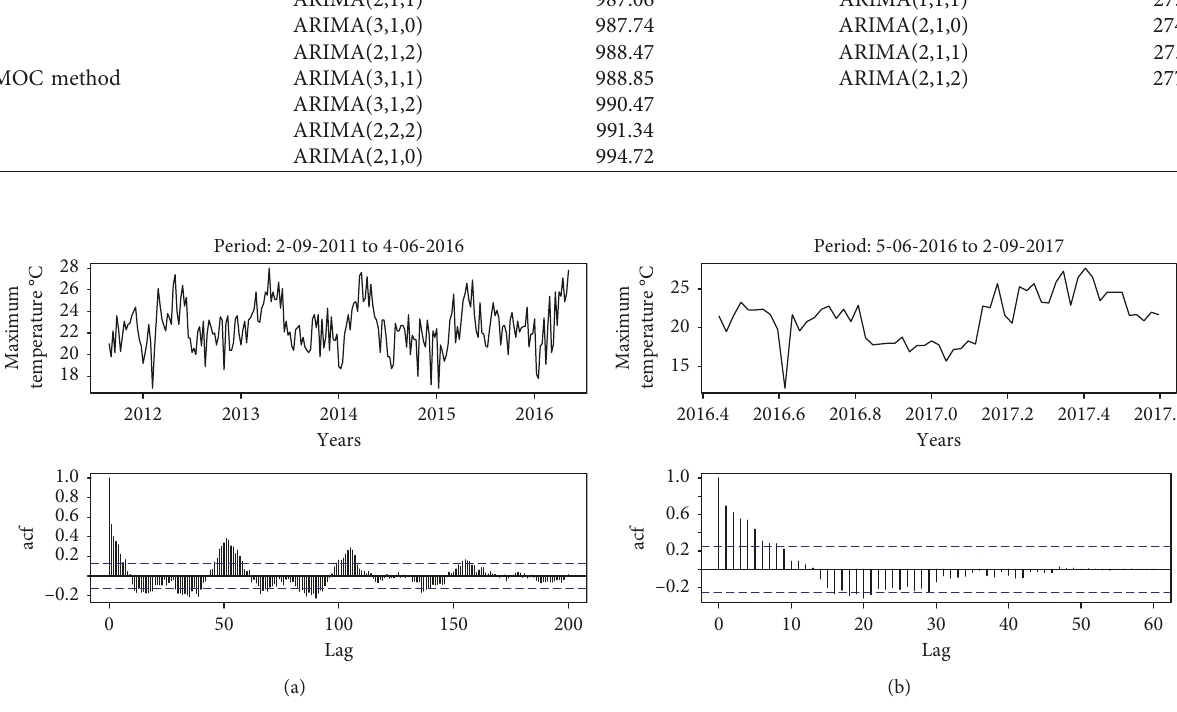
Figure 9: Partitioned time series after applying the AMOC method. (a) First data block. (b) Second data block.